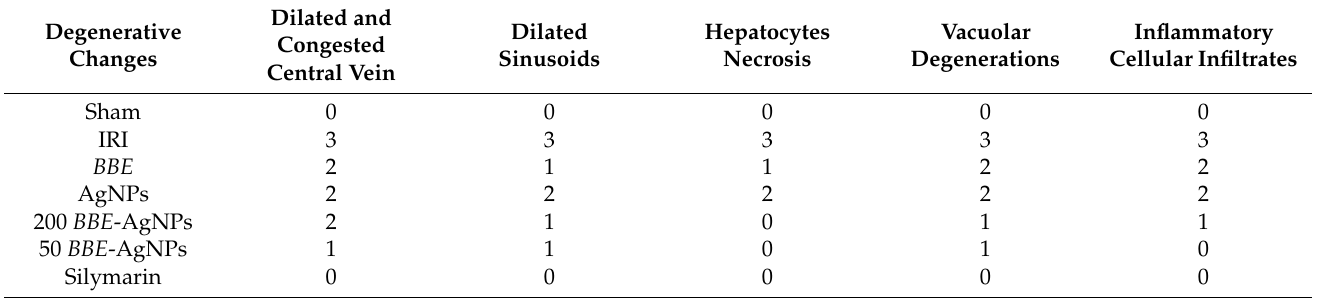
Table 3. Histopathological damage scores for liver tissues following hepatic ischemia reperfusion injury (IRI) of rats after the administration of BBE , AgNPs, 50 BBE -AgNPs, 200 BBE -AgNPs and Silymarin. IRI, ischemia/reperfusion injury; BBE , Blackberry Extract; AgNPs, silver nanoparticles; BBE -AgNPs, Blackberry loaded silver nanoparticles.